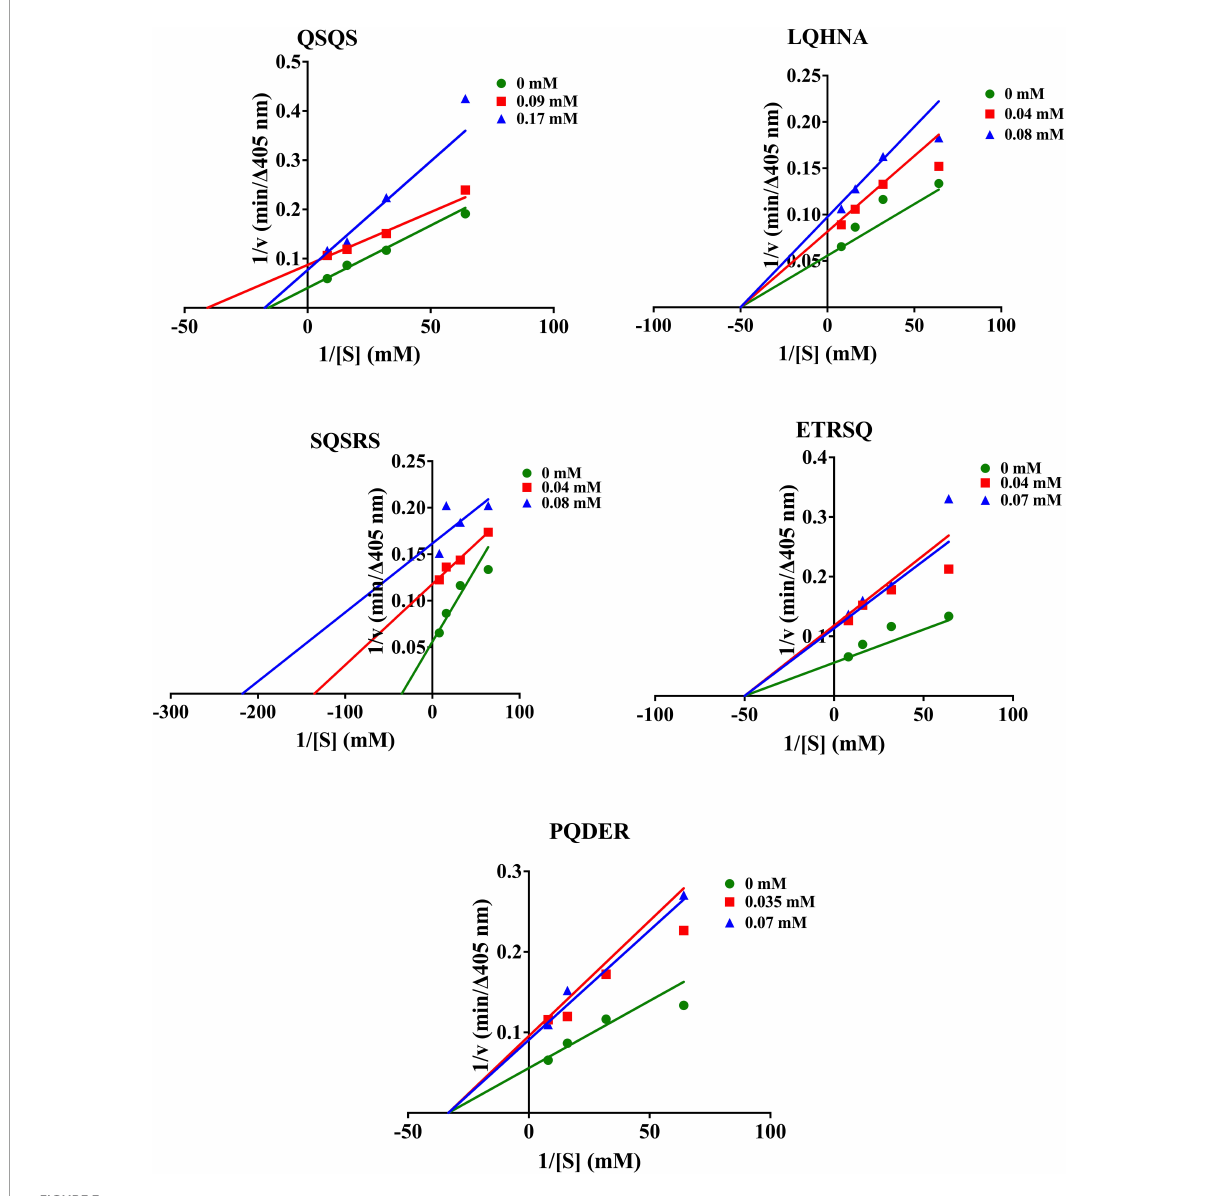
FIGURE3 Lineweaver-Burk plots of AChE inhibition by the